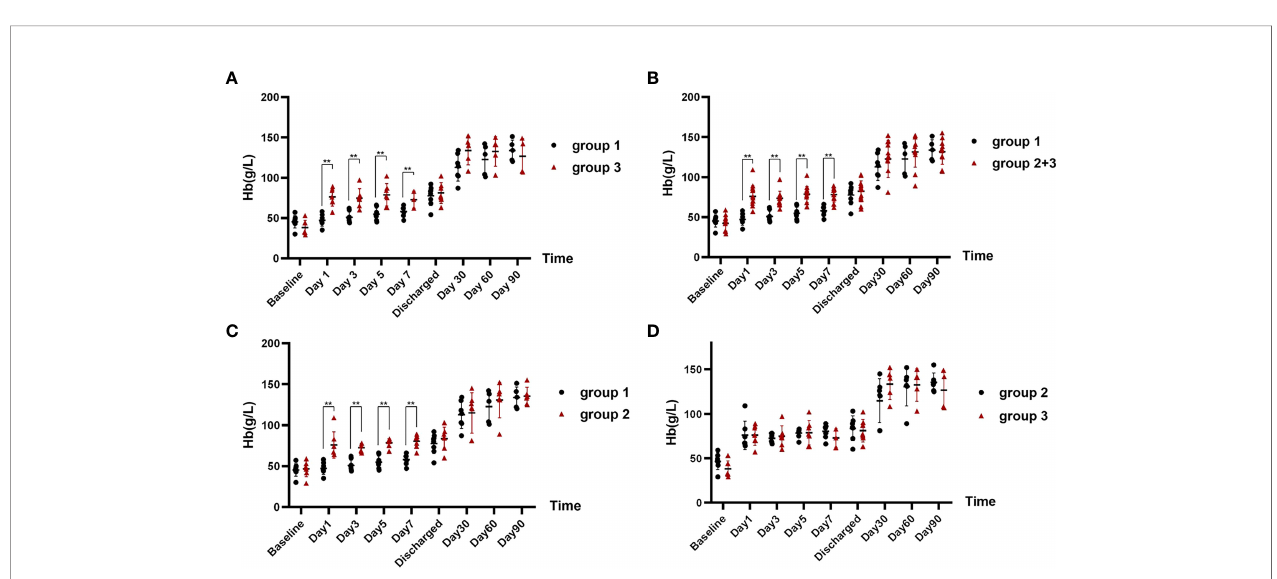
FIGURE 2 | The comparison of Hb levels at different time points in each group after corresponding therapies. (A) Hb levels of patients in group 1 after IVIG/RTX treatment vs. that of patients in group 3 after WBE. (B) Hb levels of patients in group 1 after IVIG/RTX treatment vs. that of patients in group 2 + 3 after WBE. (C) Hb levels of patients in group 1 after IVIG/RTX treatment vs. that of patients in group 2 after WBE. (D) Hb levels of patients in group 2 after WBE treatment vs. that of patients in group 3 after WBE. Baseline is the time that IVIG/RTX begins in groups 1 and 3 and WBE therapy begins in group 2. Discharge is the time that patients are discharged from the hospital. Data are shown as the mean ± SD. Each dot plot represents an individual patient, ** p < 0.01. Group 1 (IVIG/RTX, n = 8); group 2 (WBE alone, n = 7); group 3 (IVIG/RTX ! WBE, n =